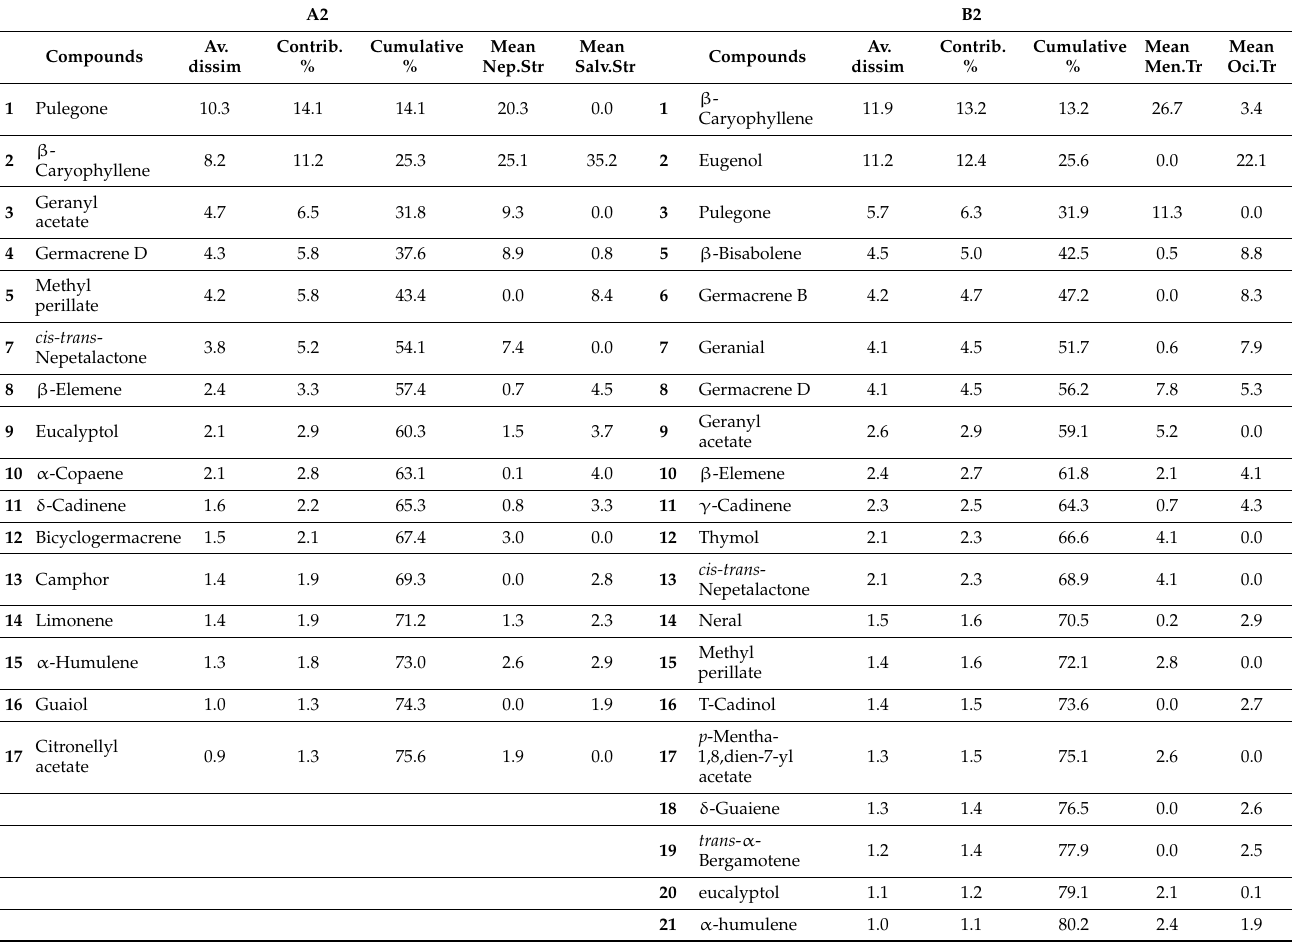
Table 3. SIMPER analyses test on subtribes ( A2 ) and tribes ( B2 ) dissimilarity on VOCs. A2